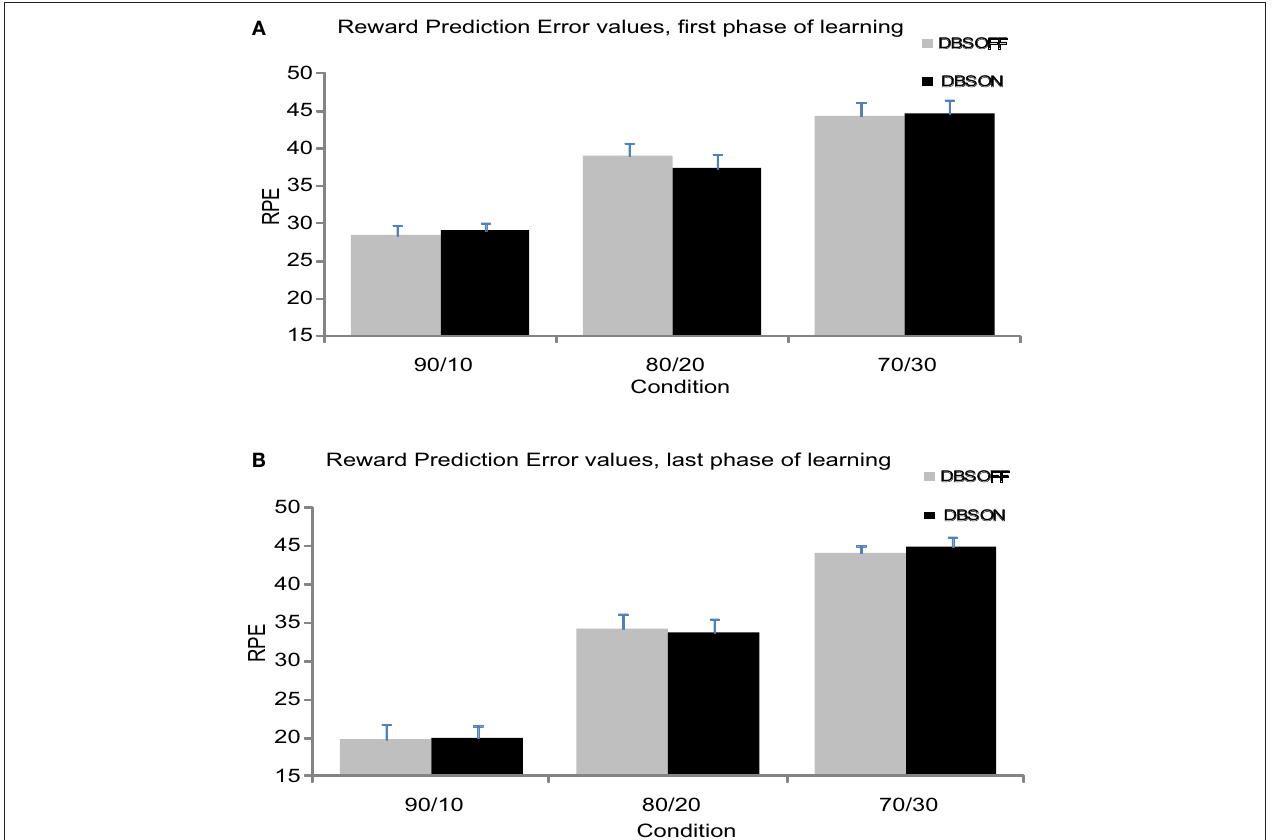
Figure 3 | (A) Mean RPE values from the first 24 trials separate for each condition. (B) Mean RPE values from the second 24 trials separate for